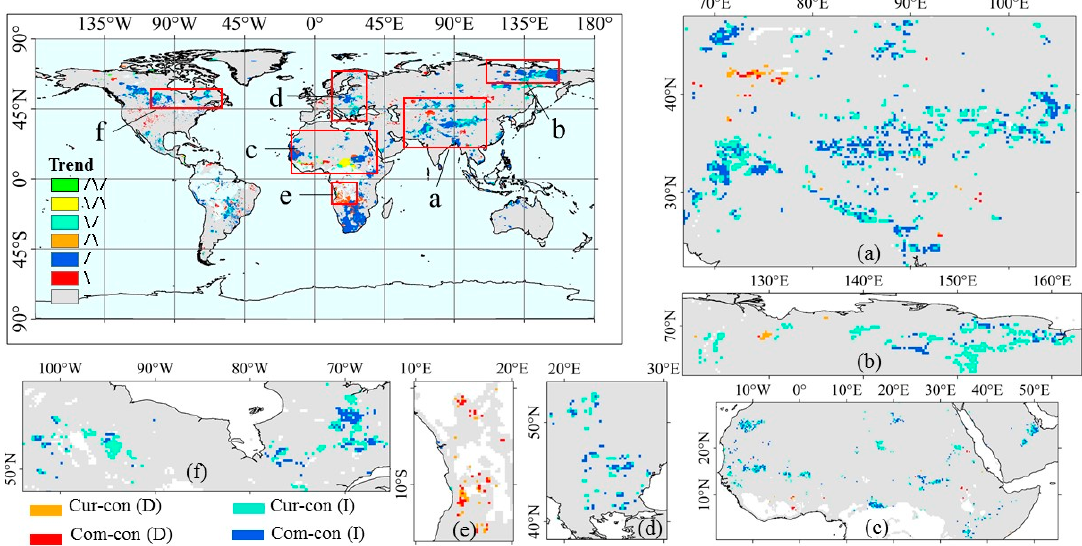
Figure 10. ( a ) Distribution of annual precipitation trends between 1979 and 2016, and ( b ) its consistency with ESA CCI SM. ( c – f ) Close-up view on specific regions exhibiting consistency.